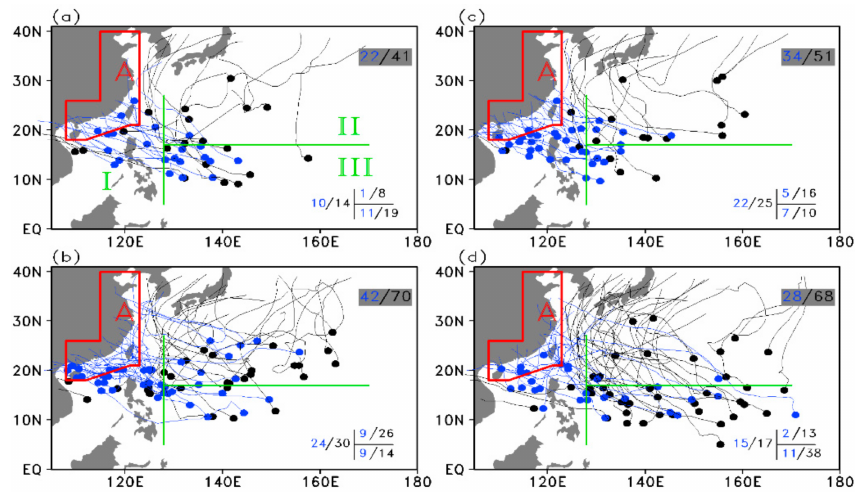
Figure 2. The genesis locations (dots) and tracks (curves) of TCs during ( a ) PC1–H, ( b ) PC1–L, ( c ) PC2–H, and ( d ) PC2–L over the WNP basin. Two green lines divide the whole WNP basin into three subregions (regions I, II, III), and the red box marks the east coast of China. The number on the top-right indicates the total TC number (black is the TC genesis number over the WNP basin, blue is the landing TCs that reached region A), and the numbers on the bottom-right indicate the TC number in these three subregions. See text for detailed information about the three subregions. Table 1. Correlation coefficients of the TC number (including TC genesis number over the whole WNP basin and three individual subregions and landing TCs) with the first two leading modes of the WPSH based on the 1979–2014